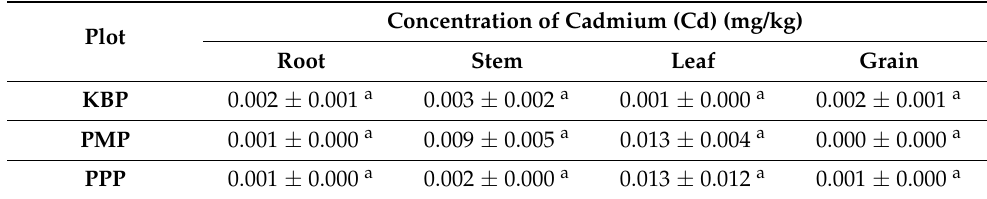
Table 4. Concentration of cadmium in different parts of paddy plants collected from Kelantan. Concentration of Cadmium (Cd) (mg/kg) Plot Root Stem Leaf Grain KBP